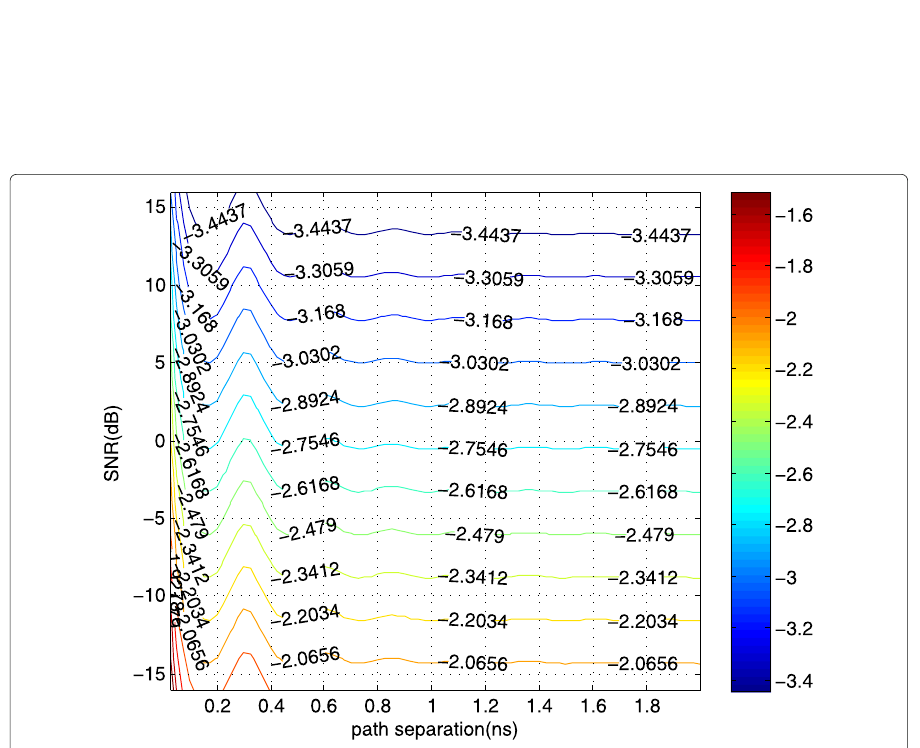
Fig. 6 Contour of ranging accuracy in log scale, log10 ( RMSE ) , as a function of path separation and SNR ∈ [ − 16,16]